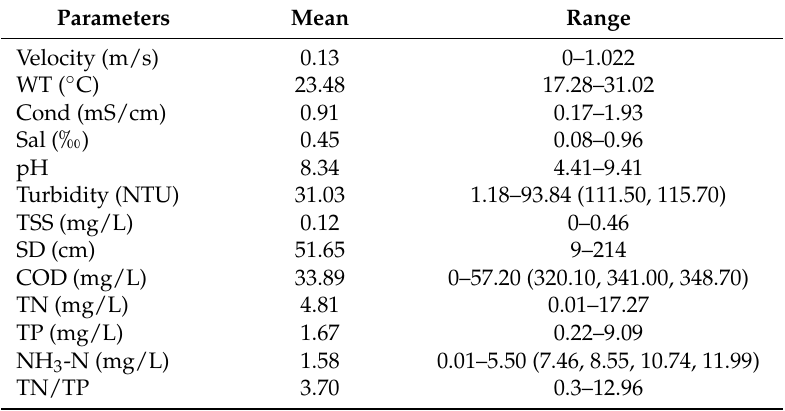
Table 4. The values of physicochemical parameters of the Ying